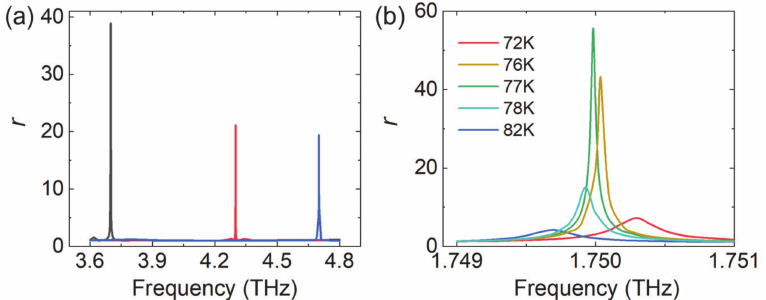
Figure 9. ( a ) Reflection amplitude as a function of frequency when di ff erent SRRs are used with pump intensity of I = 8 W / mm 2 . ( b ) Reflection amplitude at low temperatures when I = 0.35 W / mm 2